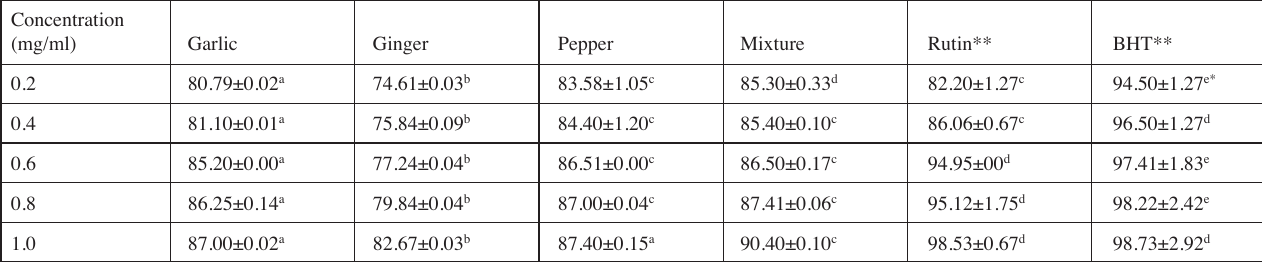
Tab. 2: Percentage (%) Nitric oxide scavenging activity of the aqueous extracts of garlic, ginger, pepper and their mixture Concentration